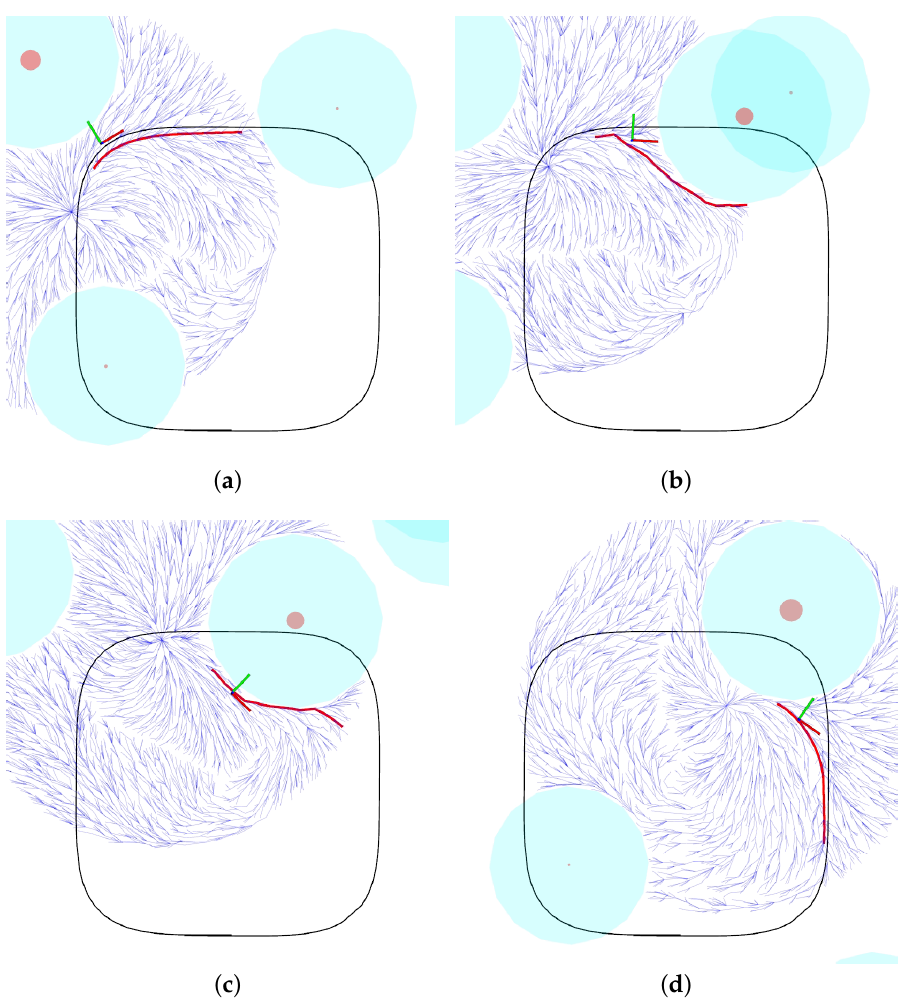
Figure 13. Four snapshots of our experiment detailing the behavior of the motion planner. The black line represents the target curve specified by the vector field. From the robot’s estimated position, the RRT* tree (in blue) grows inside a circle of radius R rrt . ( a ) No obstacles are detected and the vehicle converges to the target curve. ( b , c ) An obstacle (brown cylinder) is detected and its collision region (light blue cylinder) is estimated. The planner then computed the path (in red) outside the collision region. ( d ) After avoiding the obstacle, the MAV is able to follow the target curve. Observe that the local map, including number, position, and size of the obstacles, change along the experiment. This happens due to changes in the vehicle orientation and noise in the LiDAR